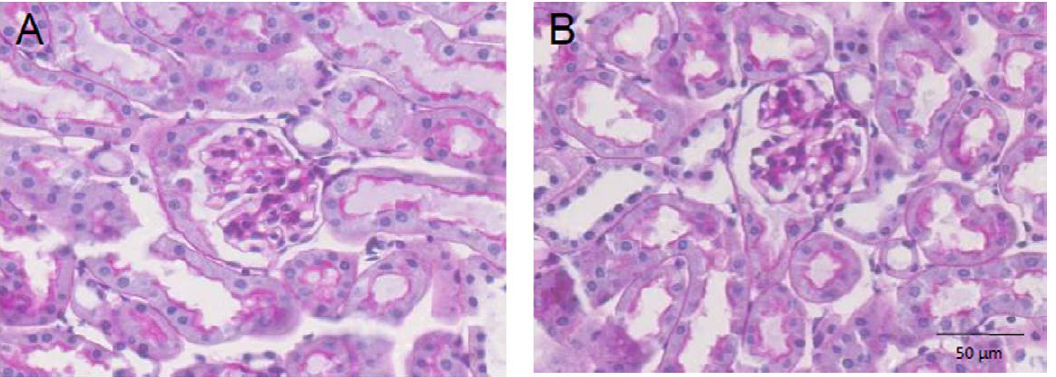
Figure 3. Renal morphology of periodic acid Schiff’s stained (PAS) glomeruli of apoE 2 / 2 mice on a combined Western-type atherogenic diet with (A) inactive- or (B)active hyaluronidase infusion. Bar=50 m